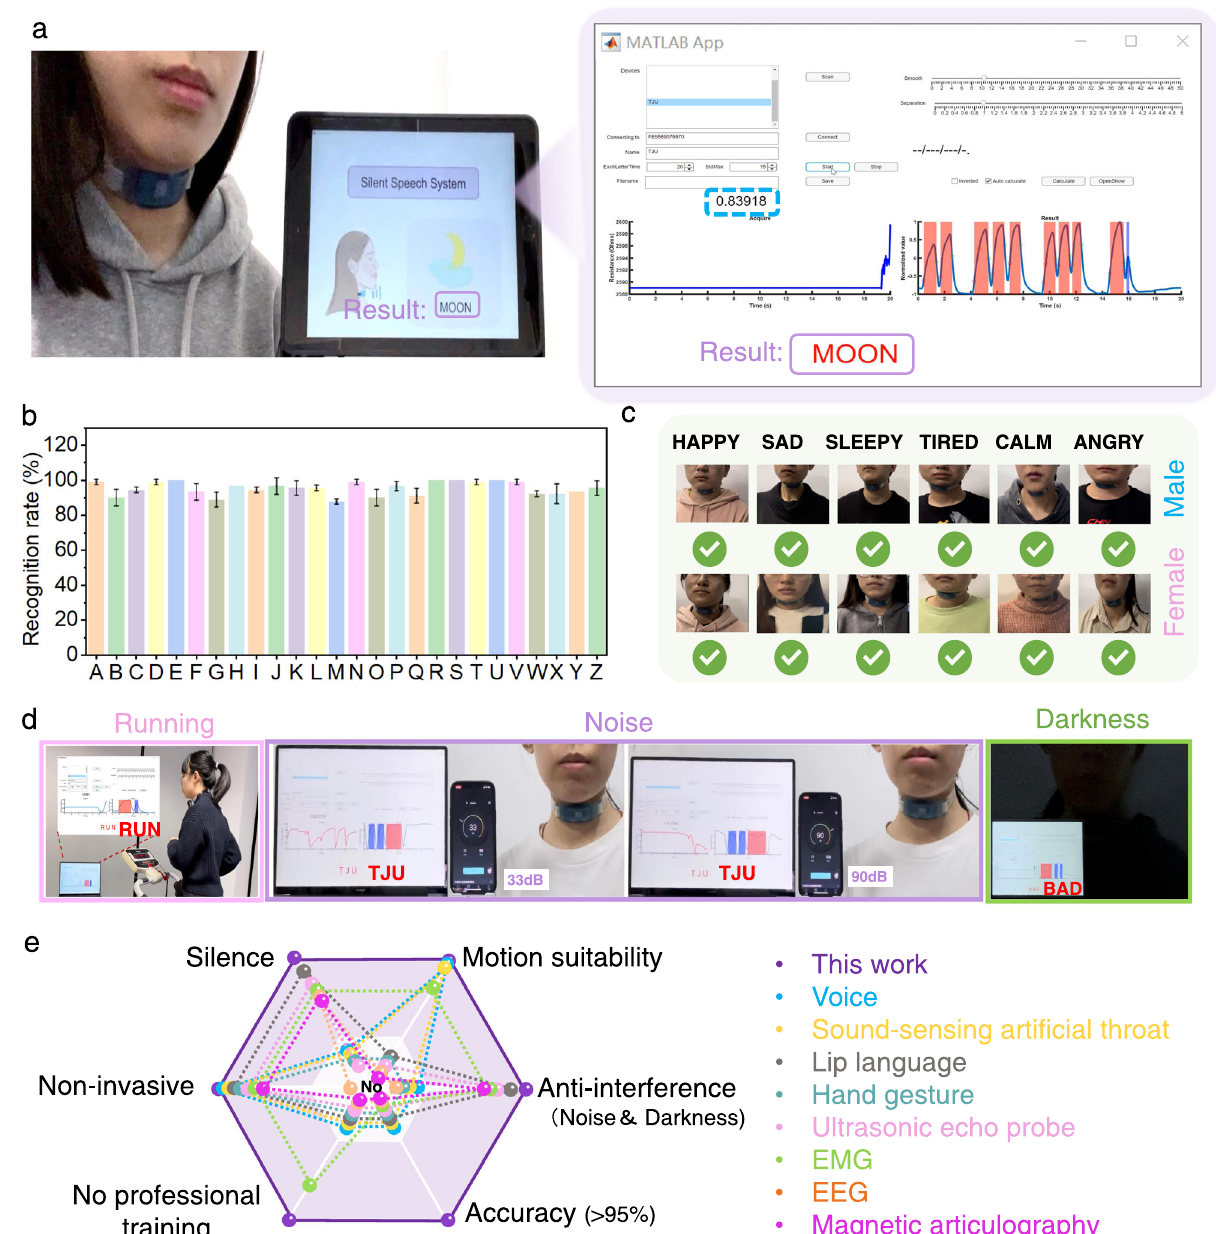
Fig. 6 | A universal silent speech recognition system (TW-SSRS). a User-friendly interface of TW-SSRS for fi nal silent speech expression (left), and an intermediate state in the real-time electrical signal display as silent speech (right). b The recog- nition rates of 26 instructions. Each instruction is repeated for 90 times. c Gender